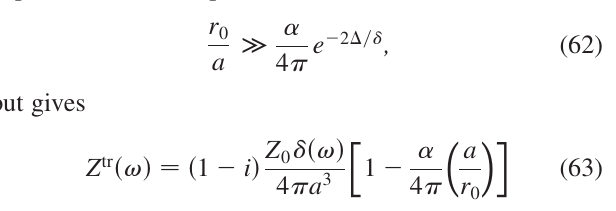
FIG. 7. (Color) Voltage induced in the wire loop by the dipole harmonics of the azimuthal B (cid:7) field of a single beam particle, (cid:1) ¼ 0 : 01 cm . Other parameters are the same as in Fig.